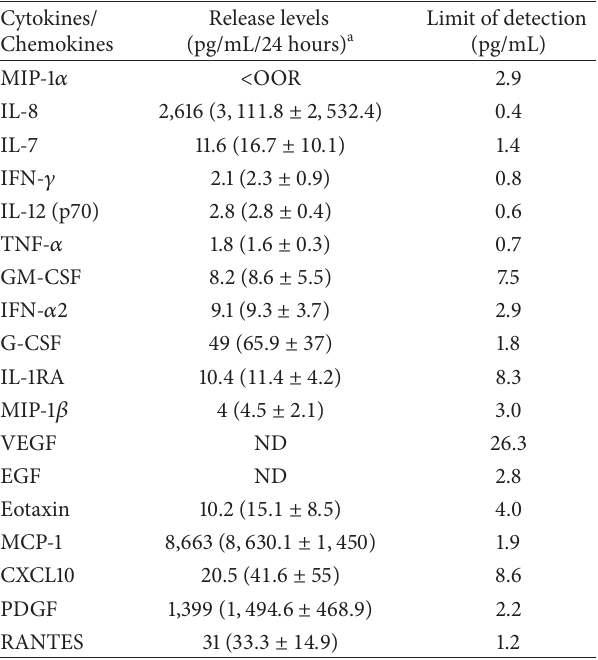
Table 2: Baseline release of cytokines/chemokines and growth factors by pathological